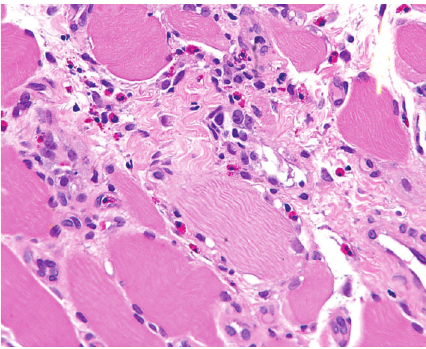
Figure 1: Biopsy of left vastus lateralis showing an abundance of